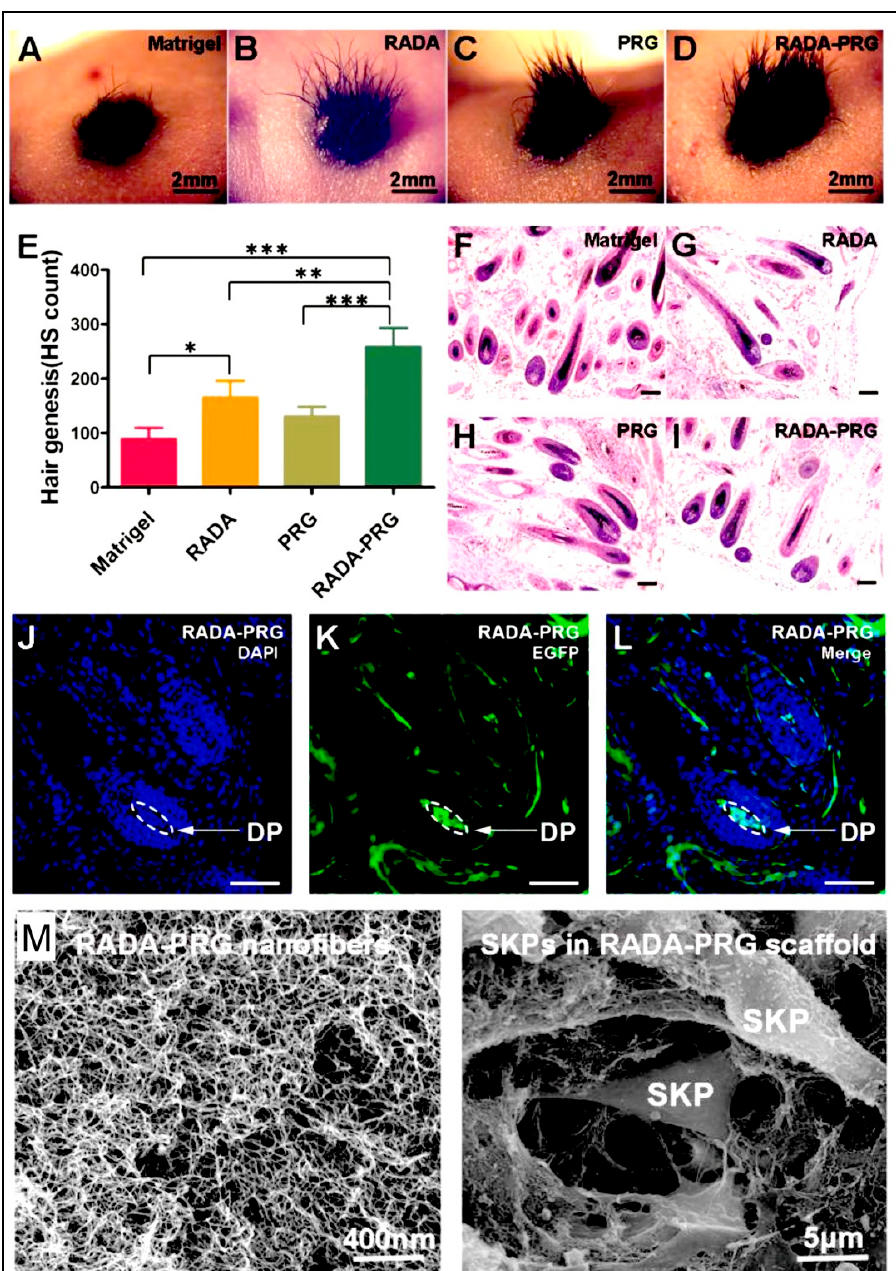
Figure 12. De novo hair follicle regeneration by self-assembling peptide hydrogel. ( A – D ) Illustration of hairs genesis after three weeks post-transplantation of neonatal mouse epidermal cells and skin- derived precursors (SKPs) in Matrigel and different peptide hydrogels into excisional wounds in nude mice. ( E ) Calculation of the number of hair shafts and the average number of hair shafts per wound (n = 4, * p < 0.05, ** p < 0.01, *** p < 0.001). ( F – L ) Histological analysis of the wound tissue after three weeks post-transplantation of neonatal mouse epidermal cells and SKPs labeled with EGFP gene in Matrigel and different peptide scaffolds. ( J – L ). Immunofluorescence analysis showed that SKPs contributed to the dermal papilla in the hair follicle and numerous cells (green) in the dermis. Representative images of wounds receiving transplanted cells in RADA-PRG hydrogel. ( M ) SEM images of RADA-PRG scaffold (left) and its interactions with SKPs (right). Reprinted with permission from Ref. [230], Copyright 2016,